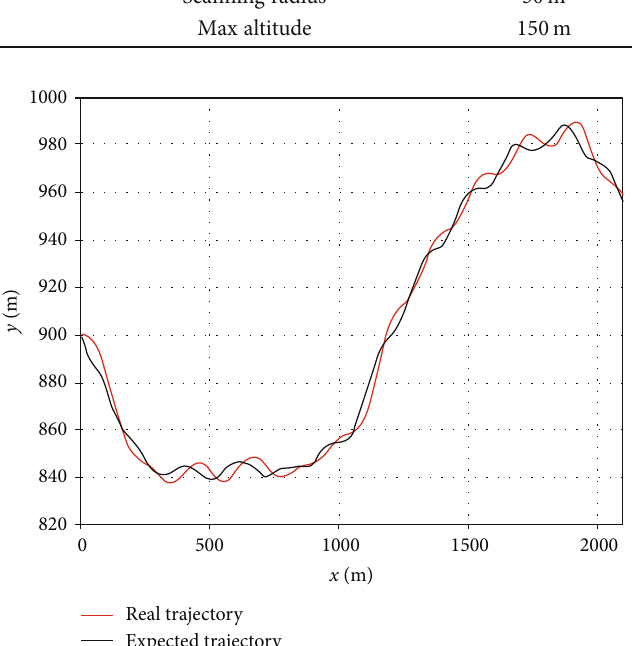
Figure 7: Expected trajectory (gradient-driven) and real trajectory (adjusted by Simulink) — only minor discrepancy is observed, even at the highest object velocity of 10